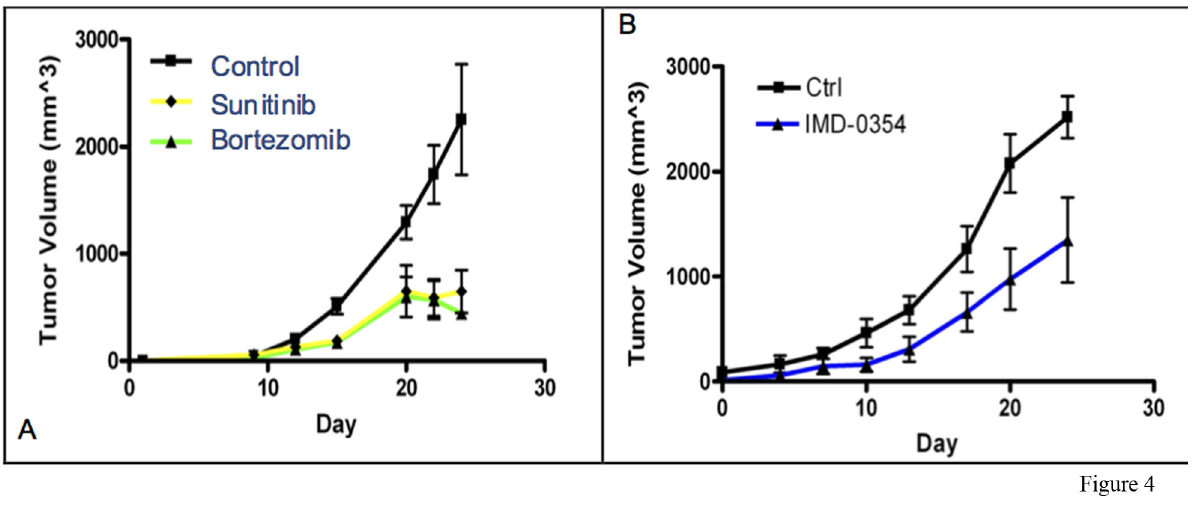
Figure 4. A) Chordoma xenograft tumor growth curves in control mice and mice treated with Sunitinib (p = 0.026) or Bortezomib (p = 0.015) measuring from the start of treatment. B) Chordoma xenograft tumor growth curves of control mice and mice treated with IKK-inhibitor IMD-0354 (p = 0.03) measuring from start of treatment. Each data point is the mean tumor volume, and error bars show the standard error, of the entire cohort on the indicated day. Data were analyzed for significance using a 2-way ANOVA, with p < 0.05 considered significant. doi: